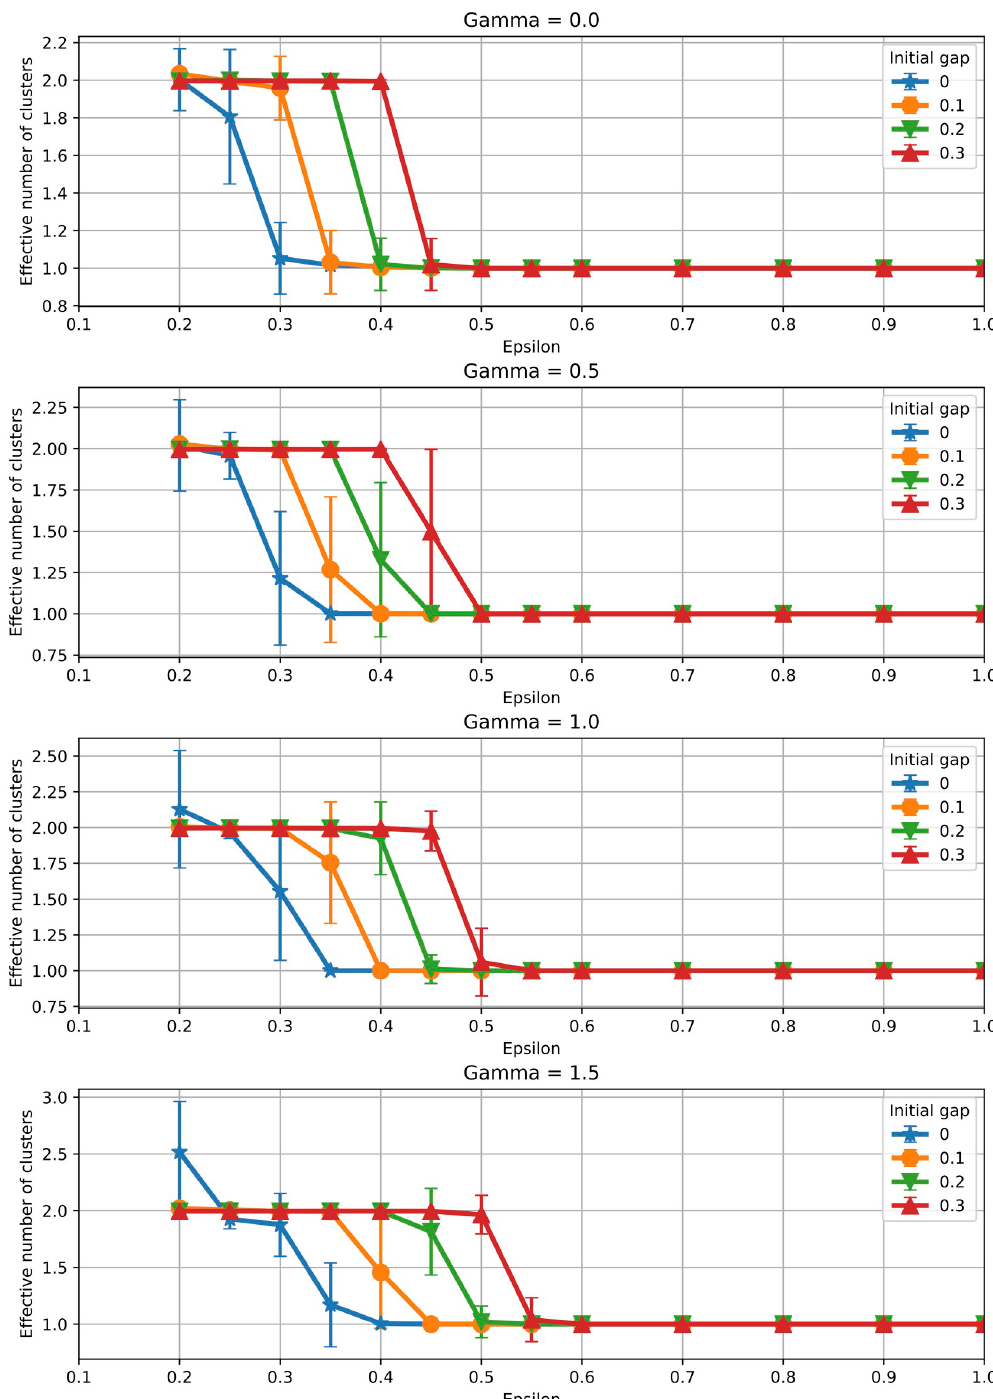
Fig 9. Initial condition: Number of clusters. Effect of the initial condition on the effective number of clusters (averages over 100 runs).